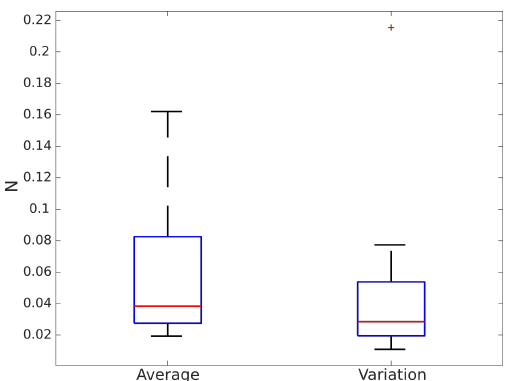
Figure 6. Heel strike differences between the treadmill and the Optotrak system.